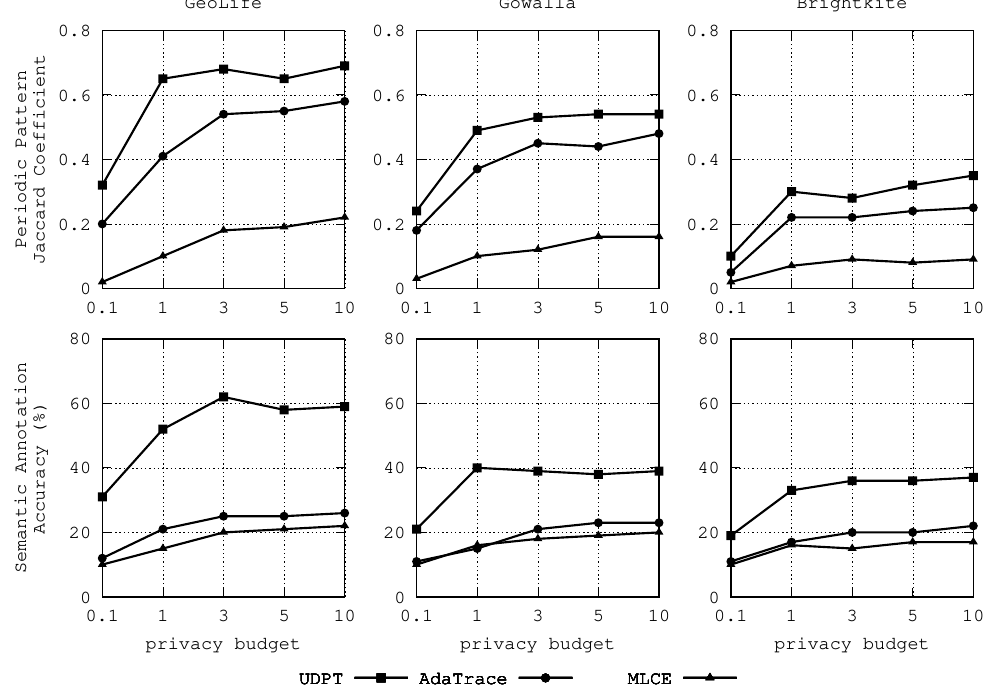
Figure 3. Comparison of UDPT against existing works in terms of semantic utility under different privacy budgets on three datasets. A higher ordinate indicates a better